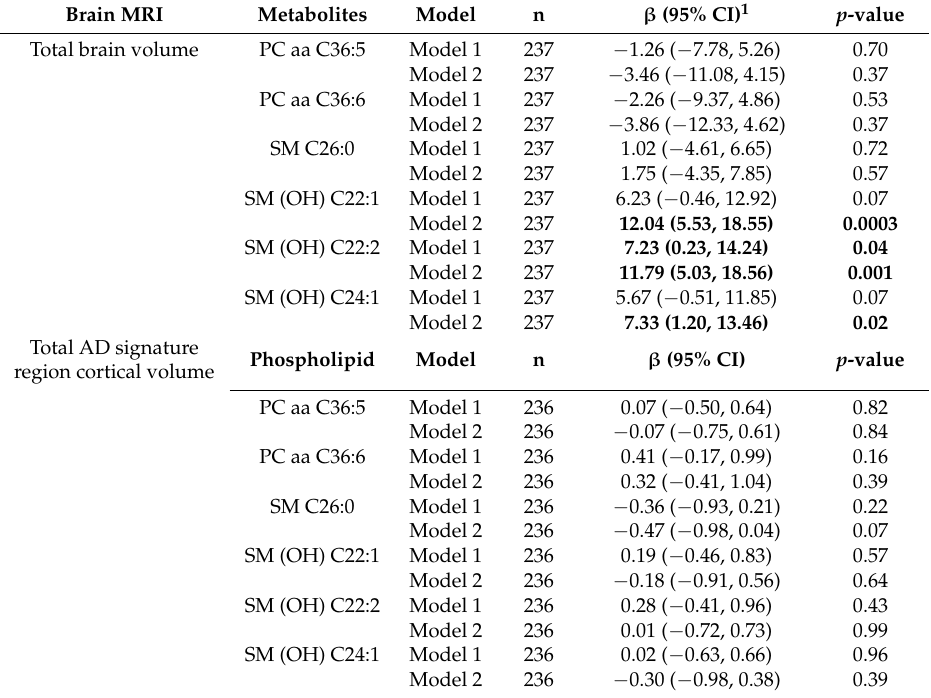
Figure 1. Forest plots of beta coefficients (95%CI) of multivariable linear regression analyses between 6 plasma metabolites (log-transformed per 1-SD change) and Total SM(OH) and total brain volume (cm 3 ) in the ARIC study, 2011 to 2013. Model 1: Linear regression adjusted for age, race/center, sex, APOE, education level, and estimated total intracranial volume; Model 2: Model 1 with additional adjustment for body mass index, diabetes mellitus, drinking status, HDL cholesterol, smoking status, sports index, systolic blood pressure, total cholesterol, triglycerides, use of antihypertensive medications (yes or no), use of statins (yes or no), depression, and prevalence of coronary heart disease, heart failure, and stroke at the ARIC visit 5 baseline. Table 4. Weighted* linear associations of plasma metabolites (log-transformed per 1-SD difference) with brain volume MRI measures, Atherosclerosis Risk in Communities (ARIC) Study, 2011 to 2013.